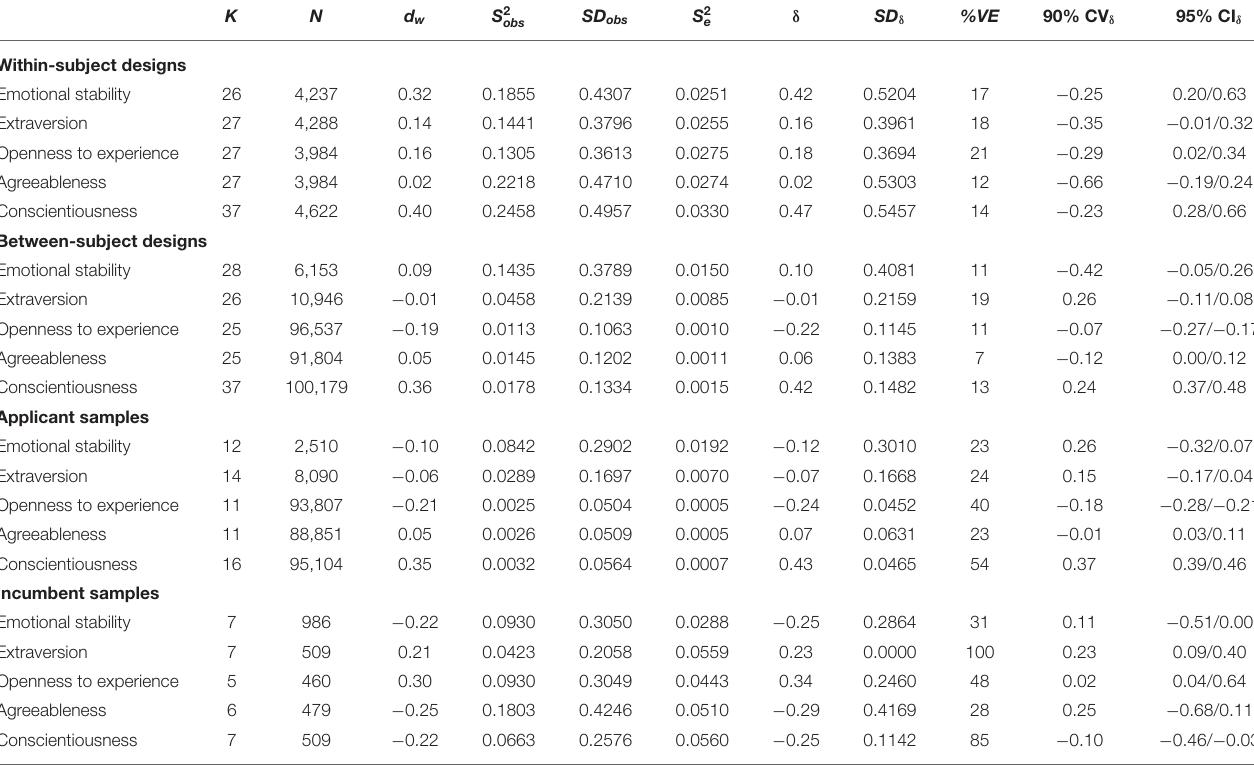
TABLE 4 | Meta-analysis of the faking resistance of the forced-choice inventories by type of